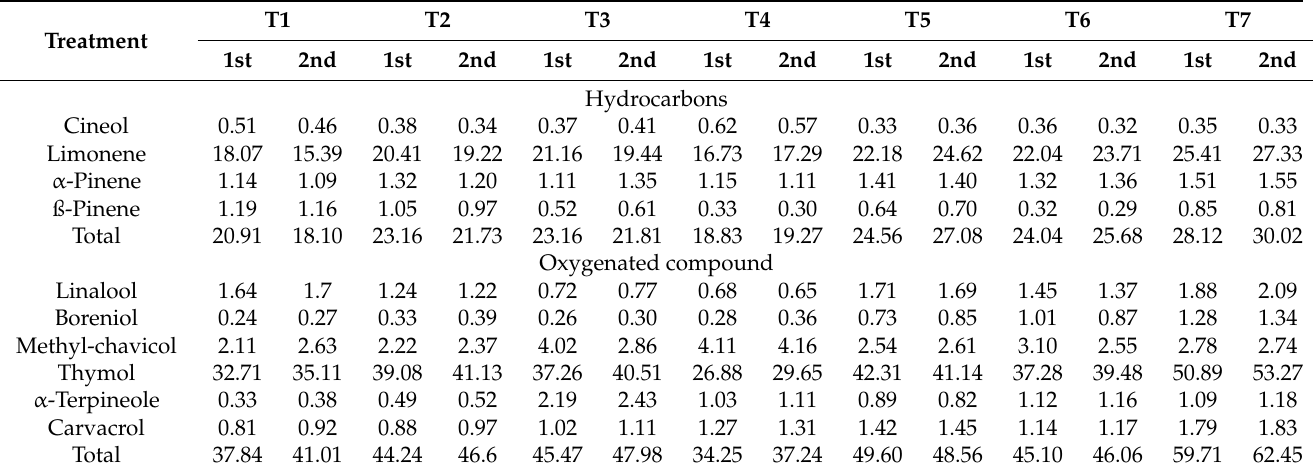
Table 10. Effect of nanoparticles on hydrocarbons and oxygenated compounds in thyme plant during 2020 and 2021 growing